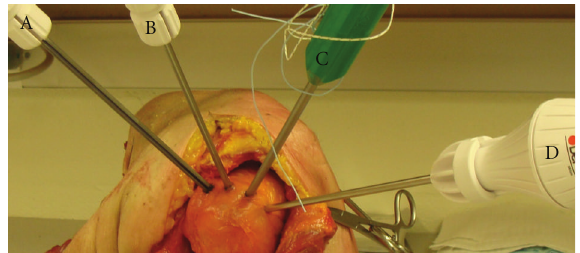
Figure 1: Transtendon insertion of the anchors. The supraspinatus and infraspinatus tendons were exposed by a superior-lateral approach, after dissecting the skin and subcutaneous tissue and retraction of the anterior portion and middle portion of the deltoid muscle. Four anchors were inserted into the humeral footprint, including the Healix Peek (A), Fastin RC (B), Bio-Corkscrew Suture anchor (C), and Healix Transtend